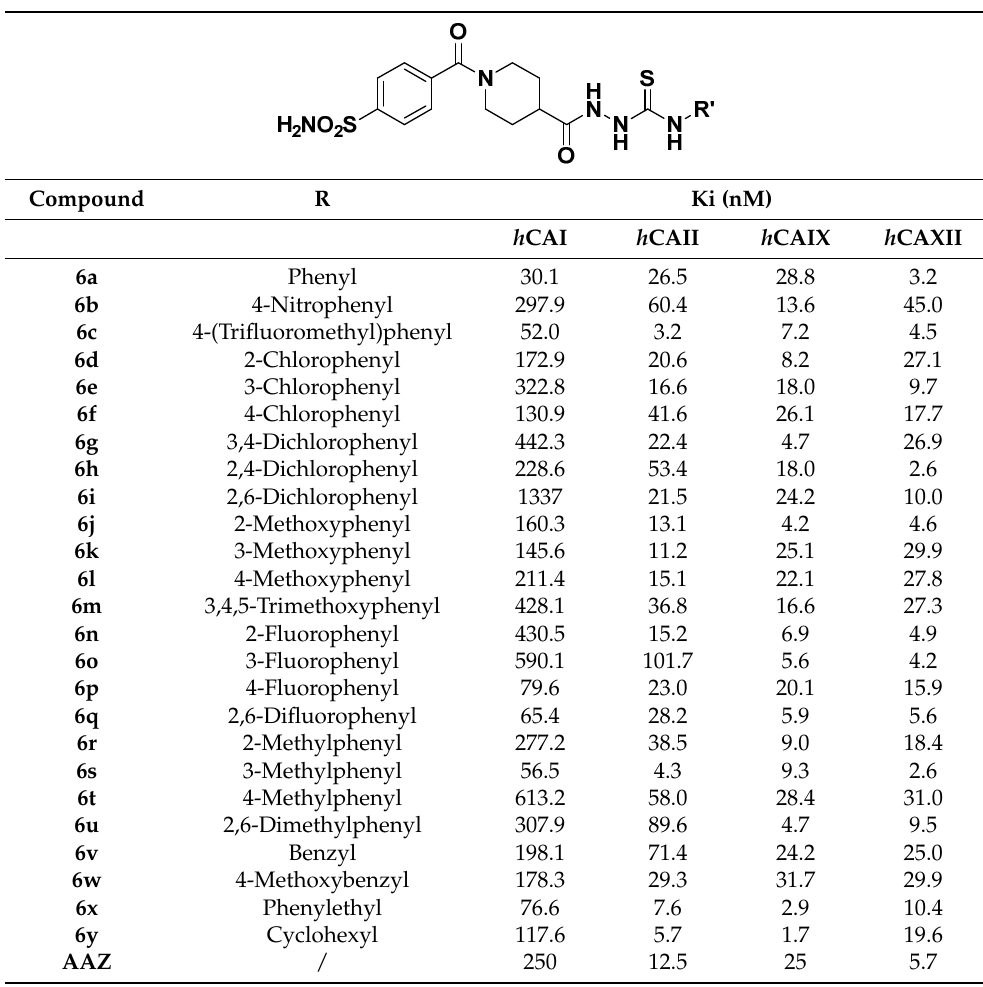
Table 2. Inhibition data of human CA isoforms CA I, II, IX and XII with sulfonamides 6a – y reported here and the standard sulfonamide inhibitor acetazolamide (AAZ) by a stopped flow CO 2 hydrase assay [23].